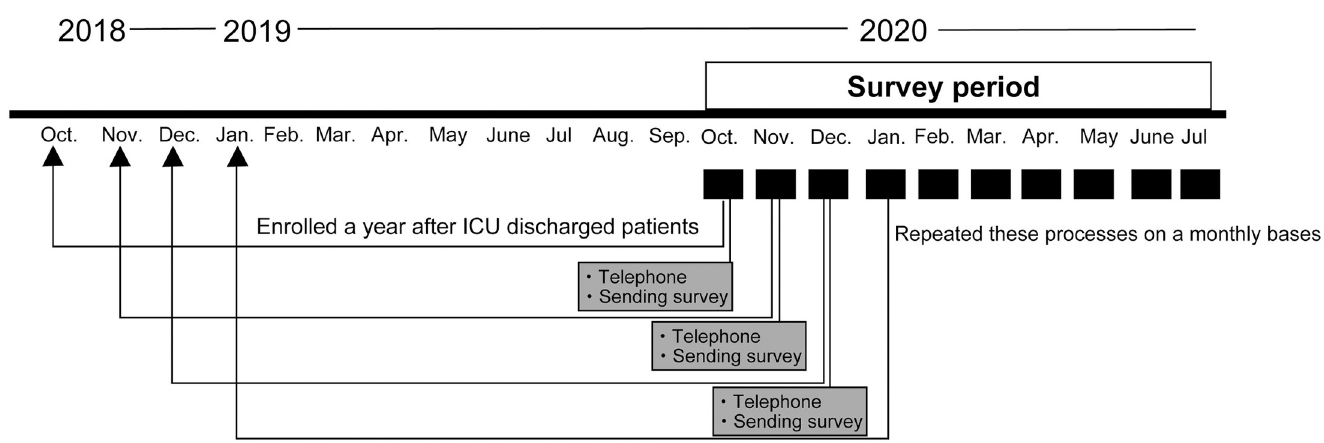
Fig 1. Schematic illustration of the study design. Each month, patients who had been discharged from ICU one year earlier were screened and contacted by telephone; thereafter, a survey set was mailed to these patients. ICU, intensive care unit.